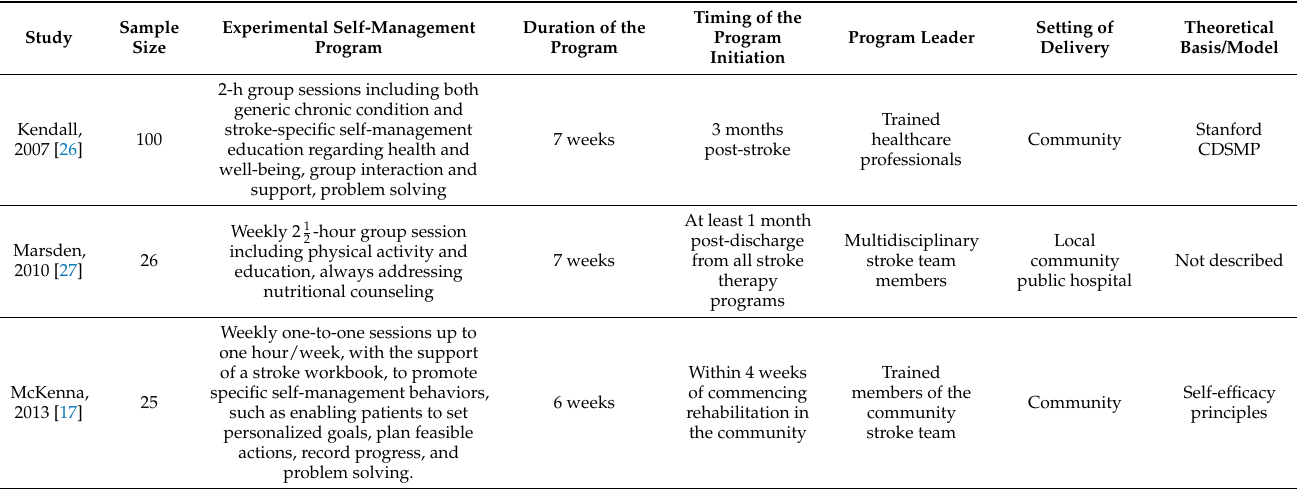
Table note: RCT—Randomized controlled trial; etc., etcetera; CDSMP—Chronic Disease Self-Management